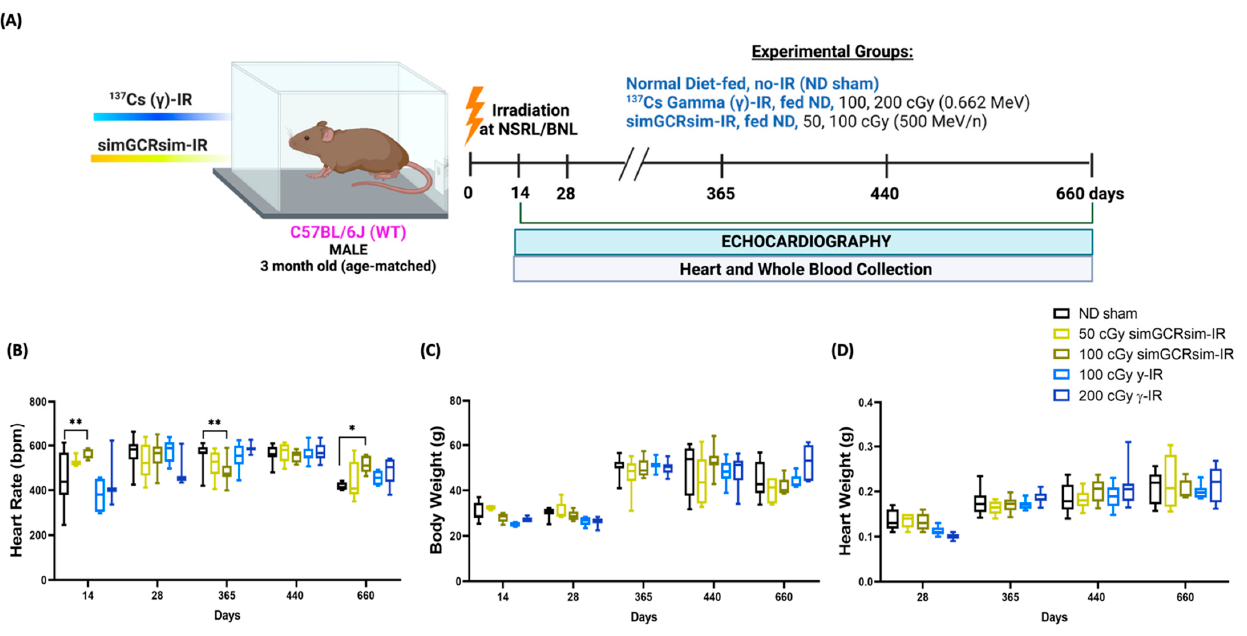
Figure 1. Physiological response of C57BL/6J male mice to gamma and simGCRsim-IR. ( A ) Three- month-old age-matched C57BL/6J wild-type mice were irradiated with 137 Cs- γ -IR (100, 200 cGy) and simGCRsim (50, 100 cGy). We assessed LV function via transthoracic echocardiography at 14, 28, 365, 440, and 660 days post IR. No-IR normal diet (ND)-fed mice served as negative control. In addition to transthoracic echocardiography, blood and hearts were collected at each time point. Created with BioRender.com. ( B ) Heart rates were obtained during transthoracic echocardiography, while mice were anesthetized using isoflurane (3–4% induction, 1–2% maintenance). ( C ) Animal